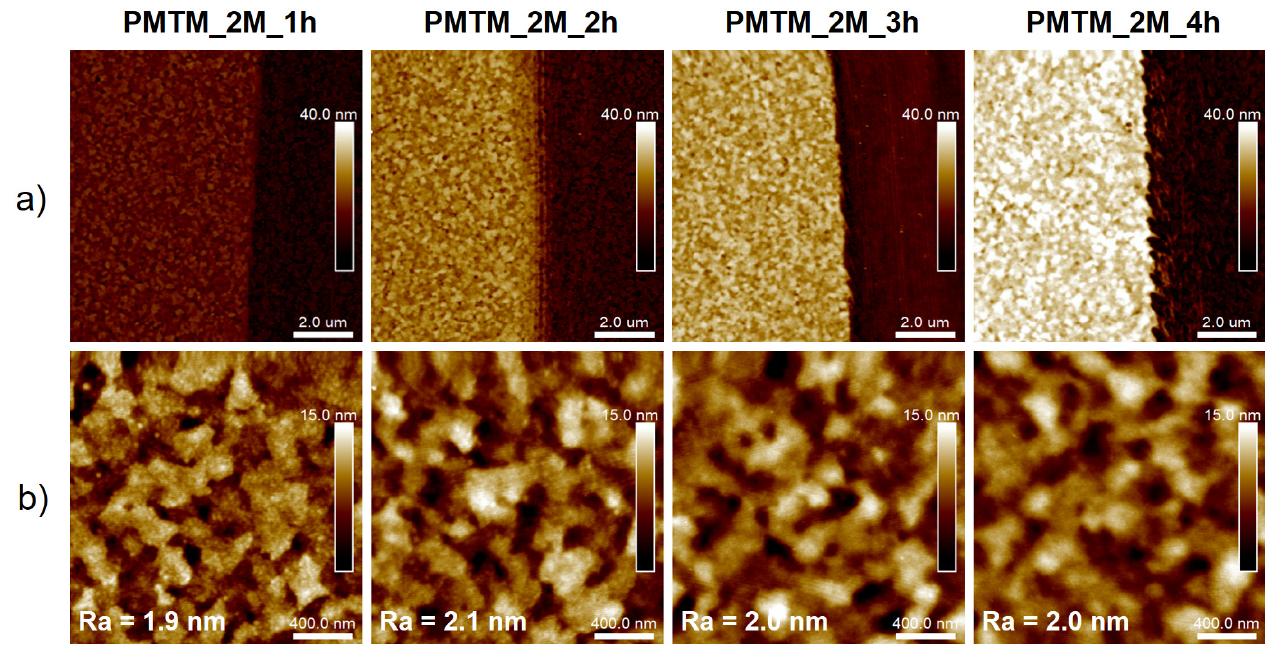
Figure 4. AFM topography images of PMTM brushes captured in air after different polymerization times at the edge of the scratch ( a ) and corresponding high-resolution images ( b ) with average roughness (Ra) values. Note that AFM images are presented on the same height scale.